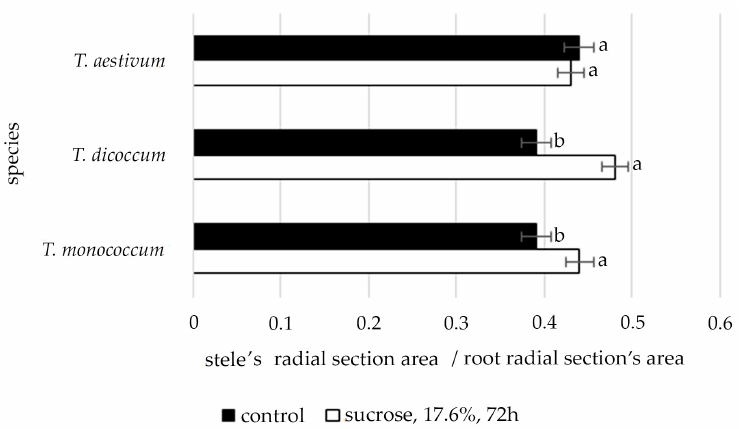
Figure 2. The changes of the stele’s radial section area/root radial section’s area ratio of wheat species under induced water deficit (sucrose, 17.6%, 72 h). Values presented are means (±SD). Different letters above the bars represent significant differences at p ≤ 0.05, n = 5 plants in each of 3 replicates for all treatments.